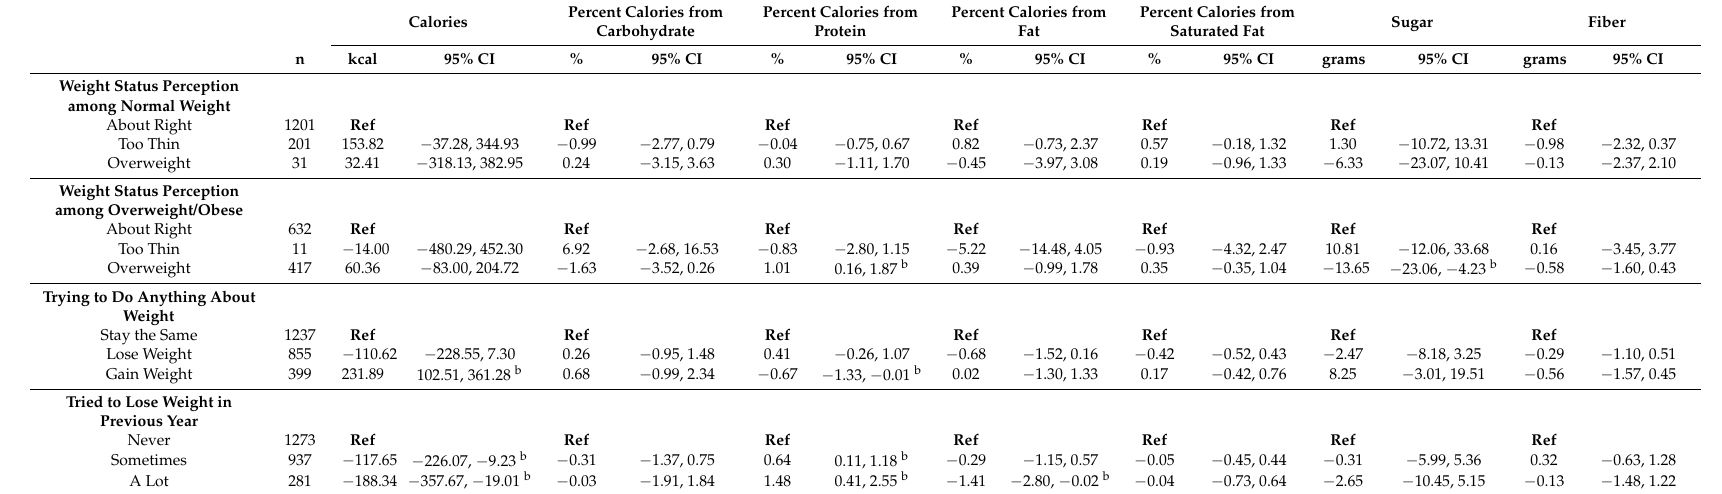
Table 3. Multivariable linear regression models estimating associations of weight status perception and weight control intentions with nutrient intakes a among boys ages 10–15 years participating in the National Health and Nutrition Examination Survey 2005–2014 (n =